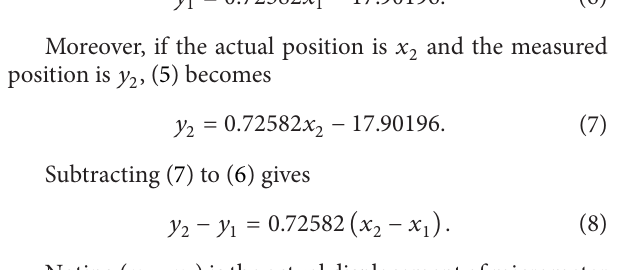
top end of fuel rod is constrained by the spacer with through holes, meaning there is a leakage flow across the